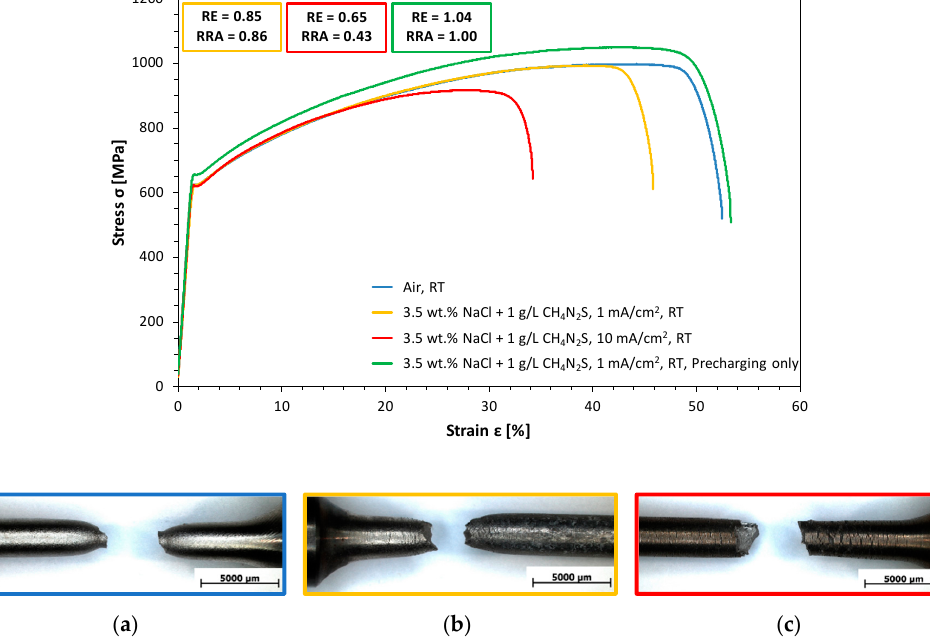
Figure 4. HISCC results for different charging methods and optical microscopy of selected samples after SSRT testing: ( a ) Air, RT ( b ) 3.5 wt.% NaCl + 1 g/L CH 4 N 2 S, 1 mA/cm 2 , RT ( c ) 3.5 wt.% NaCl + 1 g/L CH 4 N 2 S, 10 mA/cm 2 , RT.